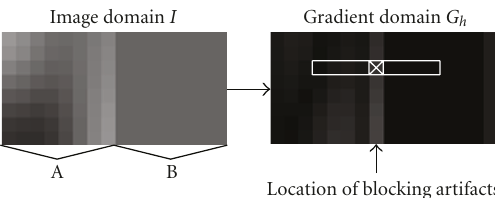
Figure 3: Local pixel-based blockiness